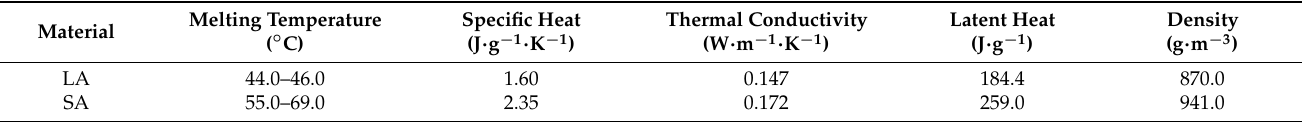
Table 1. Parameters of the